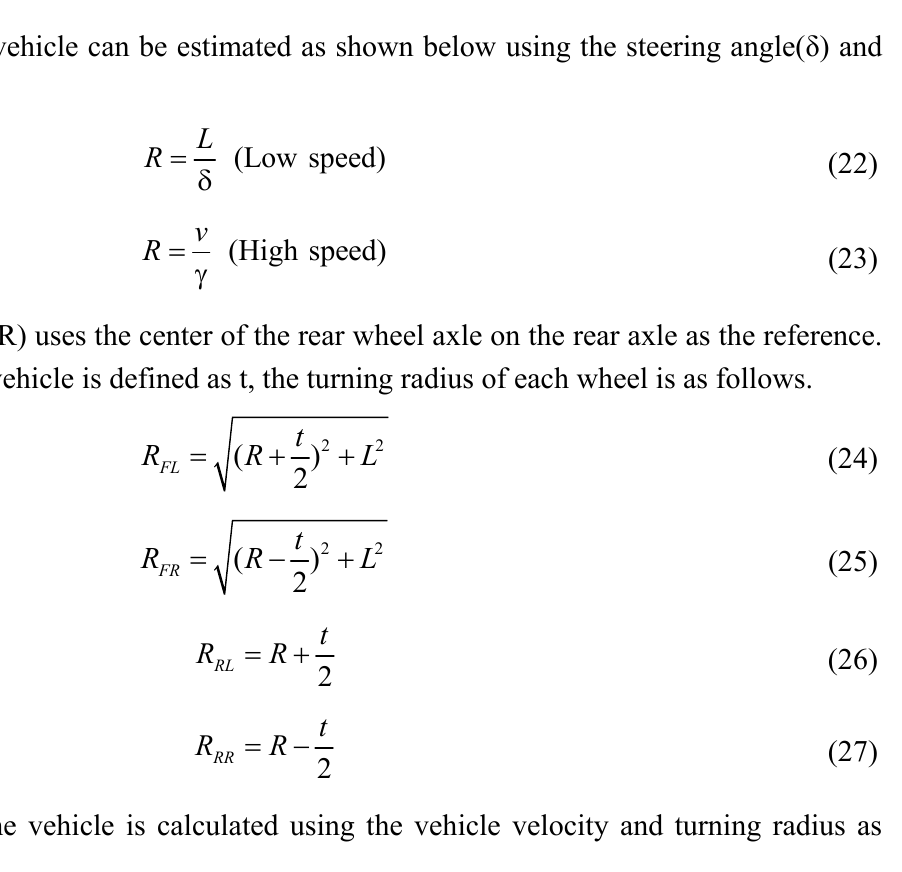
Figure 10. Turning radius of each